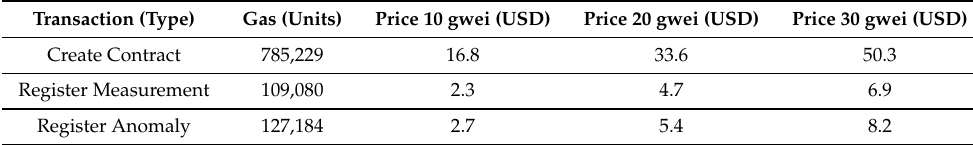
Table 5. Transaction gas usage with reference monetary costs using different gwei